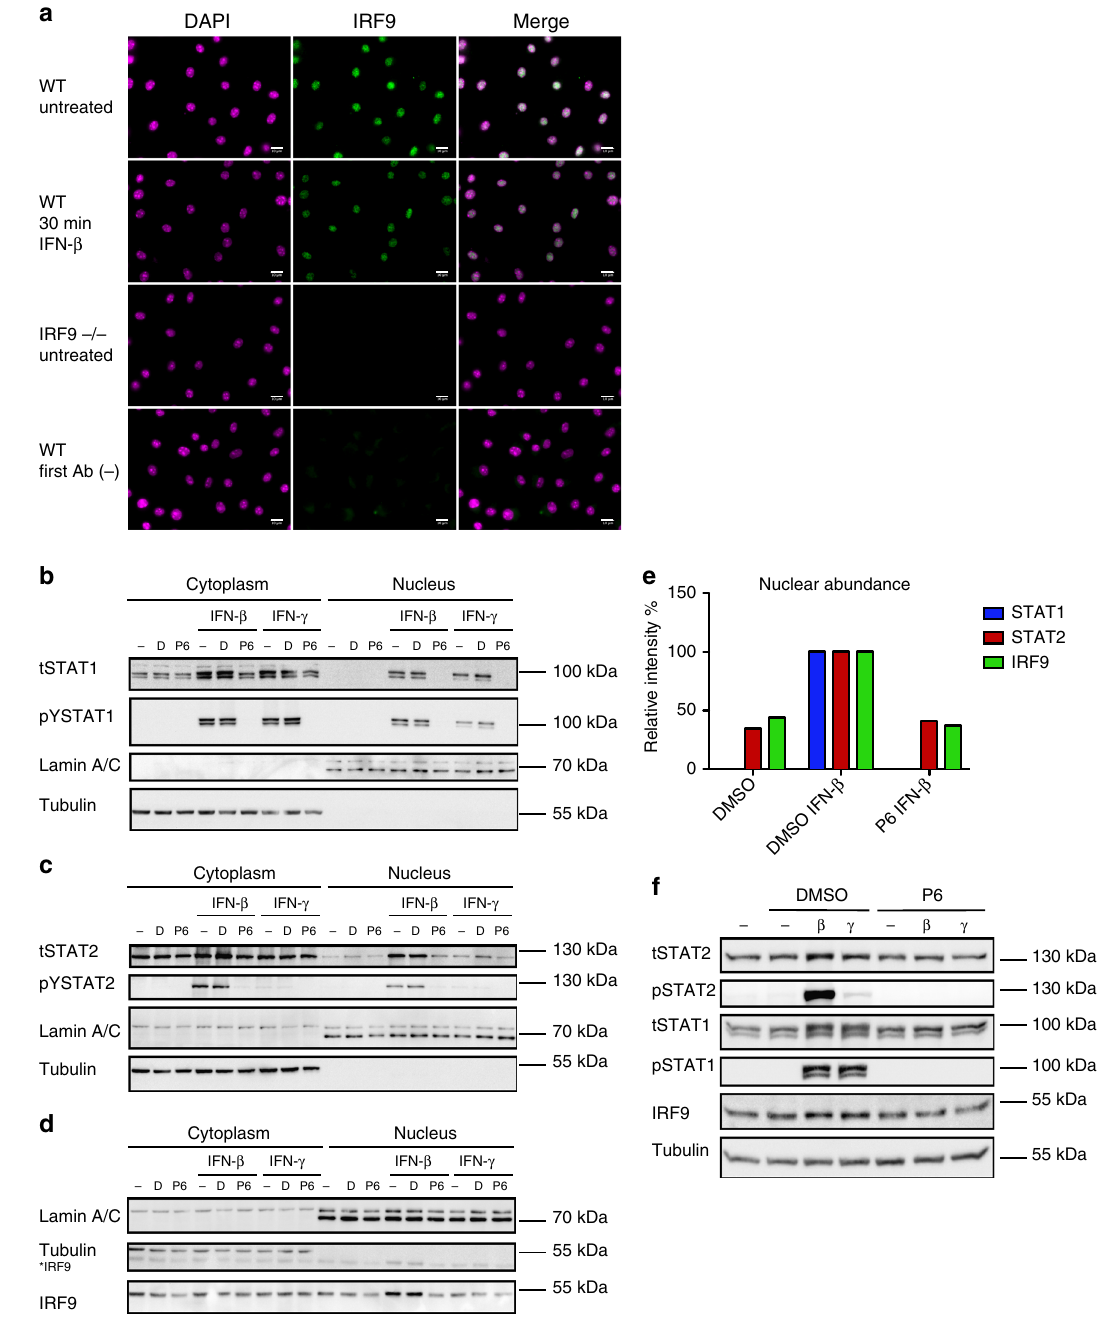
Fig. 6 Localization of STAT complexes in BMDM. a IRF9 localization as determined by immuno fl uorescence. BMDMs of wild-type (WT) and Irf9 − / − ( IRF9 − / − ) mice were left untreated or stimulated with IFN- β for 30 min. The cells were fi xed and stained with an anti-IRF9 antibody followed by Alexa Fluor ® 488-conjugated secondary antibody (green). Nuclei were stained with DAPI (magenta). First Ab ( − ) indicates the control without the fi rst antibody. The scale bars represent 10 µ m. b – d Nuclear and cytoplasmic extracts from BMDM were prepared from controls or after a 30-min treatment with IFN- β or IFN- γ and analyzed by western blot. A 2:1 ratio of the nuclear-to-cytoplasmic fraction is shown. Where indicated, 15 µ M P6 inhibitor or DMSO were added for 3 h prior to IFN treatment. Phosphorylation of STAT1 at Y701 and total STAT1 levels, as well as phosphorylation of STAT2 at Y689, total STAT2 and IRF9, and α -tubulin and lamin A/C levels were determined. e The nuclear fractions of the representative blots b – d were quanti fi ed using ImageJ software. Relative intensities of the bands were normalized to their corresponding lamin C levels. Data represent relative intensities in percent, where STAT1, STAT2, and IRF9 levels in IFN- β -treated nuclear extracts equal 100%. f Phosphorylation of STAT1 at Y701, STAT2 at Y689, total STAT1, total STAT2, IRF9, and α -tubulin was determined in whole-cell lysates of BMDM. Overall, 15 µ M P6 inhibitor or DMSO were added for 3 h prior to IFN treatment. Source data